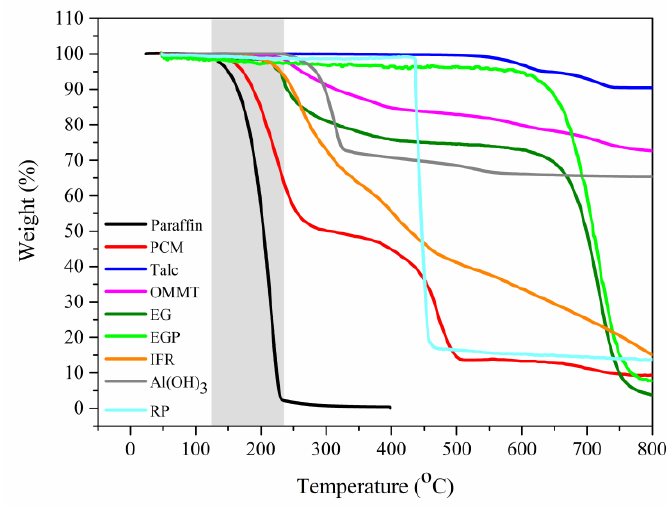
Figure 4. Thermogravimetric analysis (TGA) curves of paraffin, PCM and flame retardants (gray part: mass loss interval of paraffin).